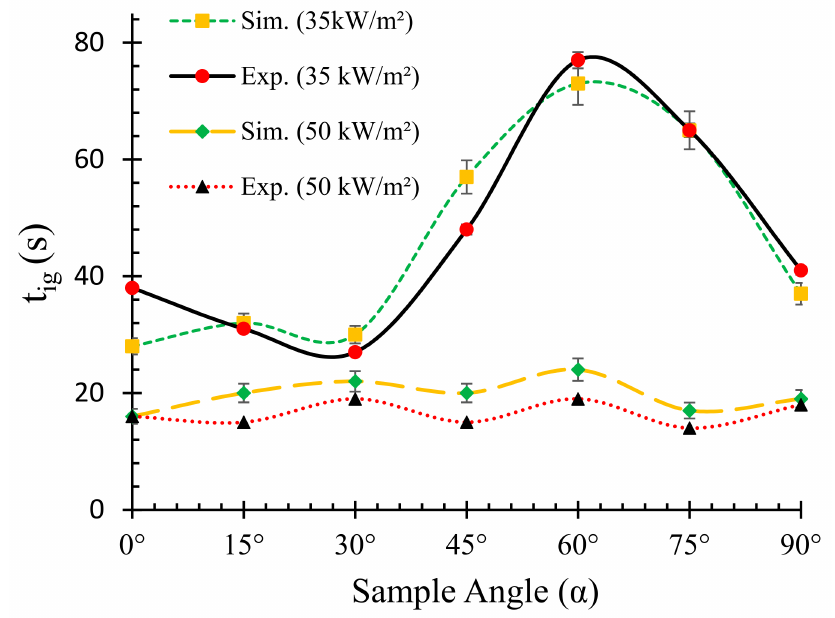
Figure 3. Relationships between ignition times ( t ig ) and sample orientation angles ( α ), H = horizontal ( α = 0 ◦ ), and V = vertical orientation ( α = 90 ◦